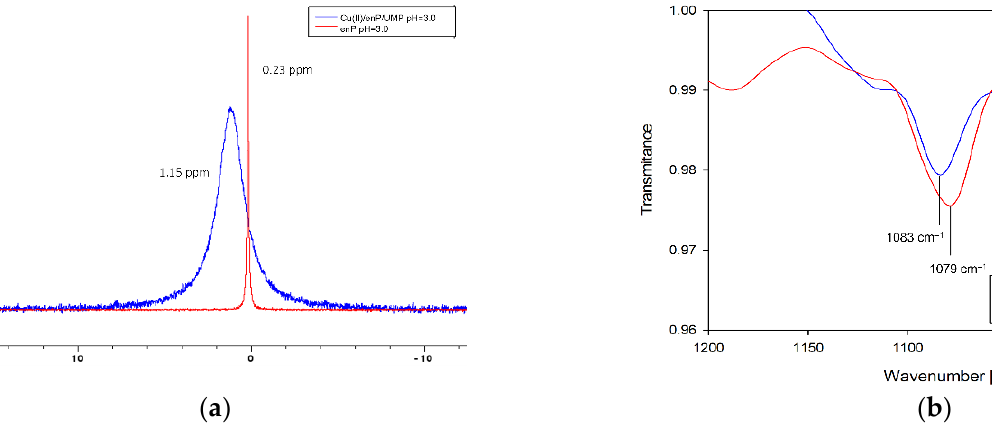
Figure 5. ( a ) 31 P NMR spectrum of ligand and ligand in Cu(enP)H 4 (UMP) complex. ( b ) IR spectra of Cu(enP)H 4 (UMP) complex compared to the free ligand at the same pH. Cu(enP)H 3 (UMP) is observed between pH near 3.0 and 7.0 and dominates at pH 5.0, binding 60% of copper(II) ions introduced into the solution. Spectral parameters change — λ max decreases to 798 nm, g ‖ = 2.40 and A ‖ = 146 ∙ 10 −4 cm −1 . These small changes indicate the inclusion of another oxygen atom in the inner coordination sphere. The shift